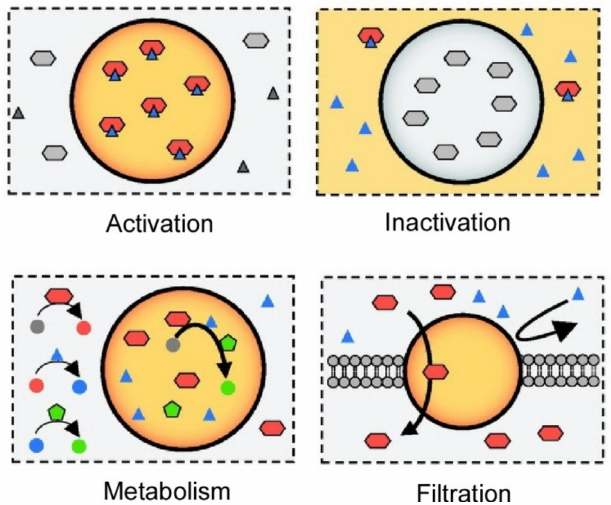
Figure 4. Phase-separated droplets composed of biomolecules for a variety of intrinsic or synthetic functions such as activation, inactivation, metabolism, and filtration. Reprinted with permission from Reference [127]. Copyright 2021, Chemical Society of